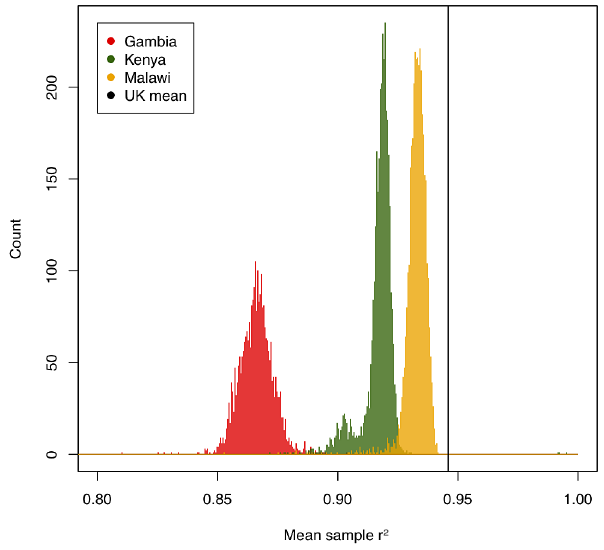
Figure 1. Per-sample imputation accuracy measured by r 2 between true genotypes and genotypes predicted by imputa- tion, averaged over imputation chunks. Black vertical line shows typical imputation accuracy in a UK population, taken from [8]. Gambian samples (red) perform worst due to the poor coverage of African variation by the Illumina 550 K platform, followed by Kenyan samples (green) on the Illumina Omni2.5M, which while dense has limited overlap with our HapMap3 reference, with Malawian samples (yellow) performing best. Note that imputation accuracy in the Kenyan sample showed a bimodal distribution driven at least partially by ethnic ancestry (Figures S12 and S13).